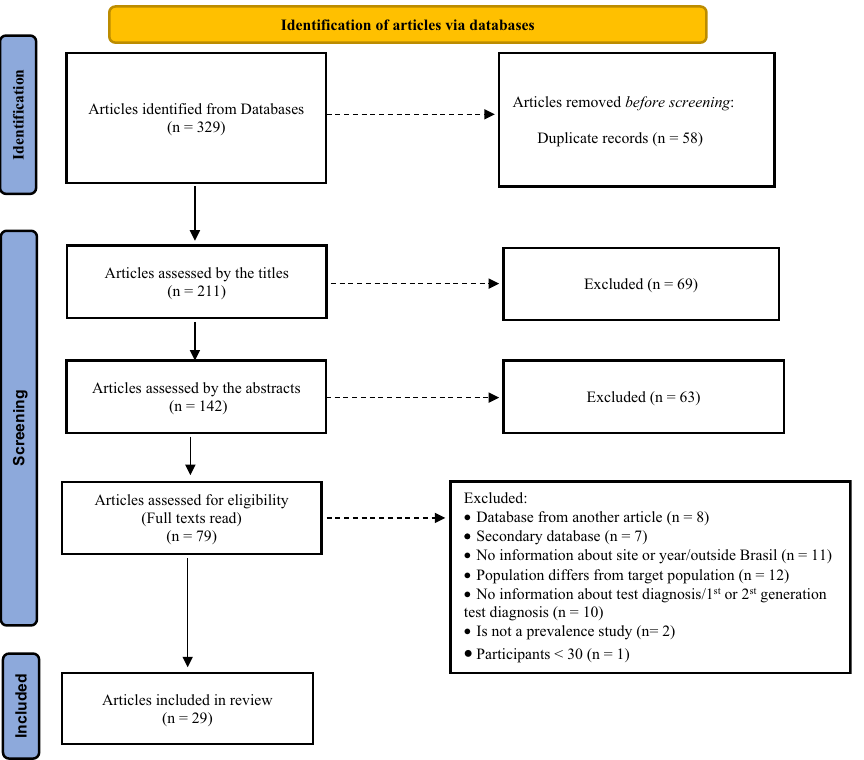
Figure 1. Flow of information and stages of the systematic